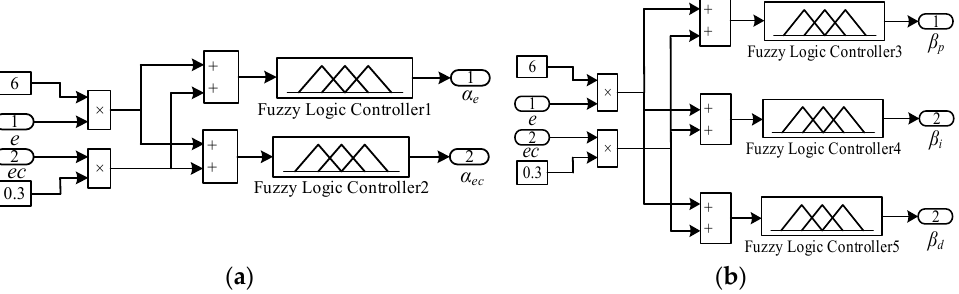
Figure 9. Domain adjustment mechanism. ( a ) Input domain contraction-expansion factor; ( b ) output domain contraction-expansion factor.